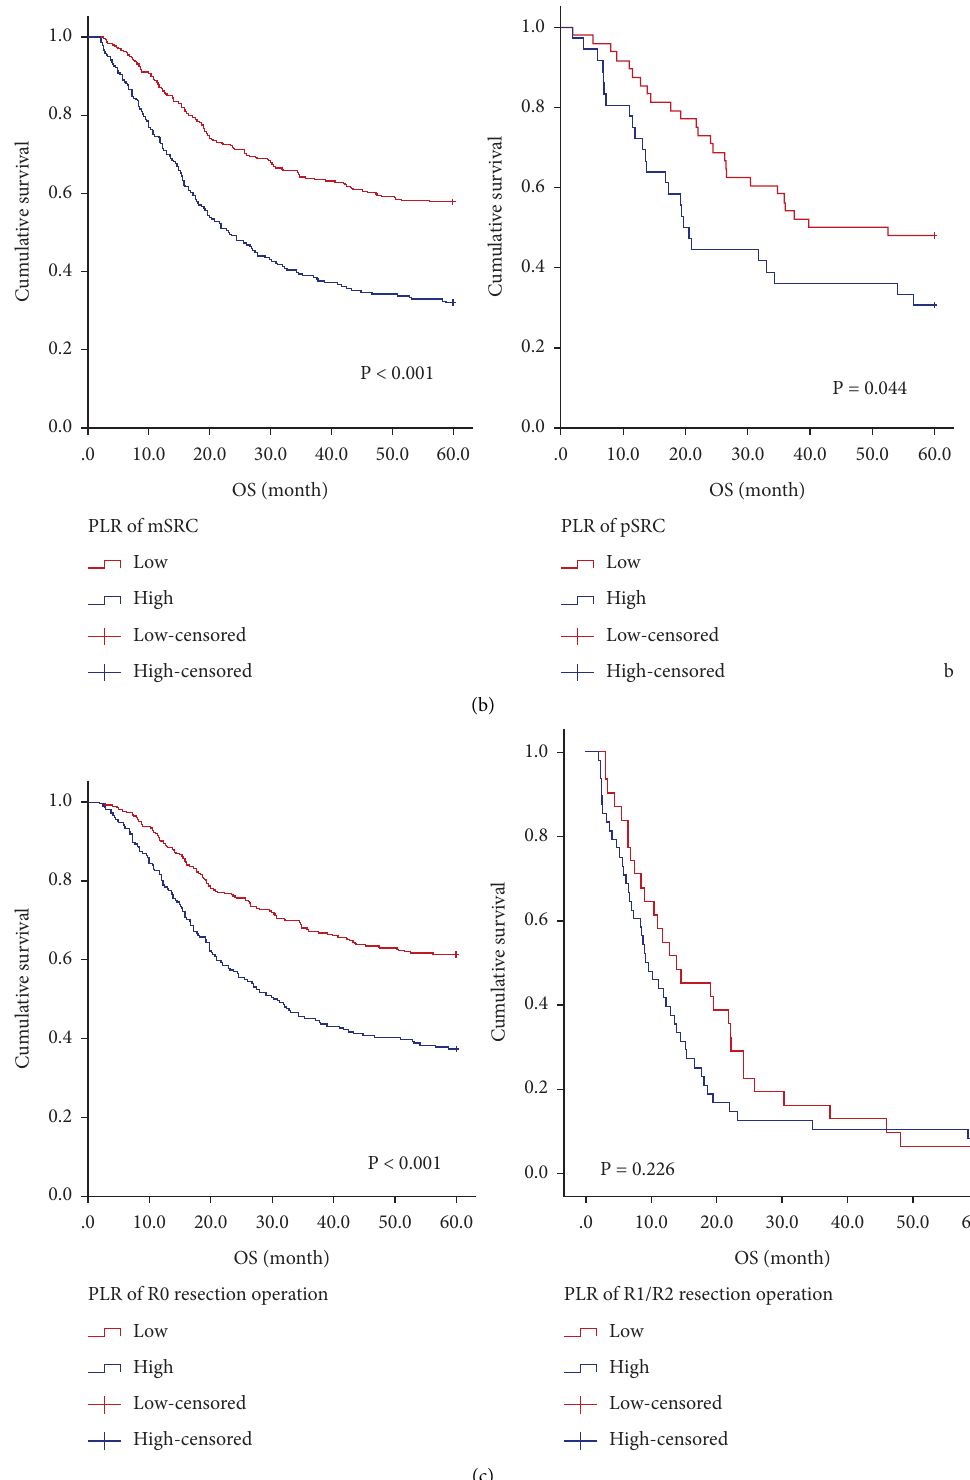
Figure 2: Kaplan–Meier analysis of OS for the PLR of all patients with gastric cancer with related characteristics. (a) pTNM stage: I+II stage and III stage. (b) mSRC or pSRC. (c) R0 or R1/R2